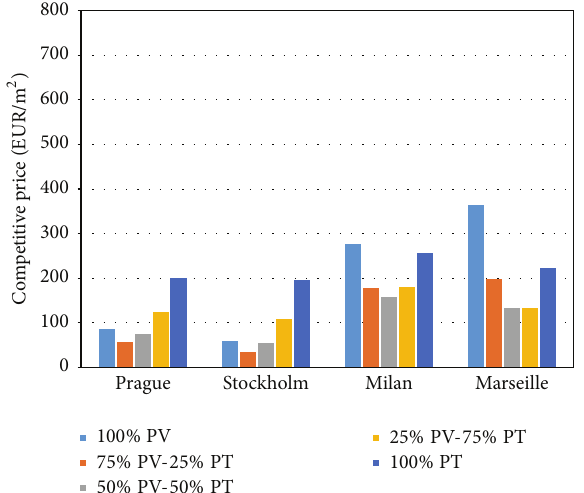
Figure 7: Competitive specific price of unglazed hybrid PVT